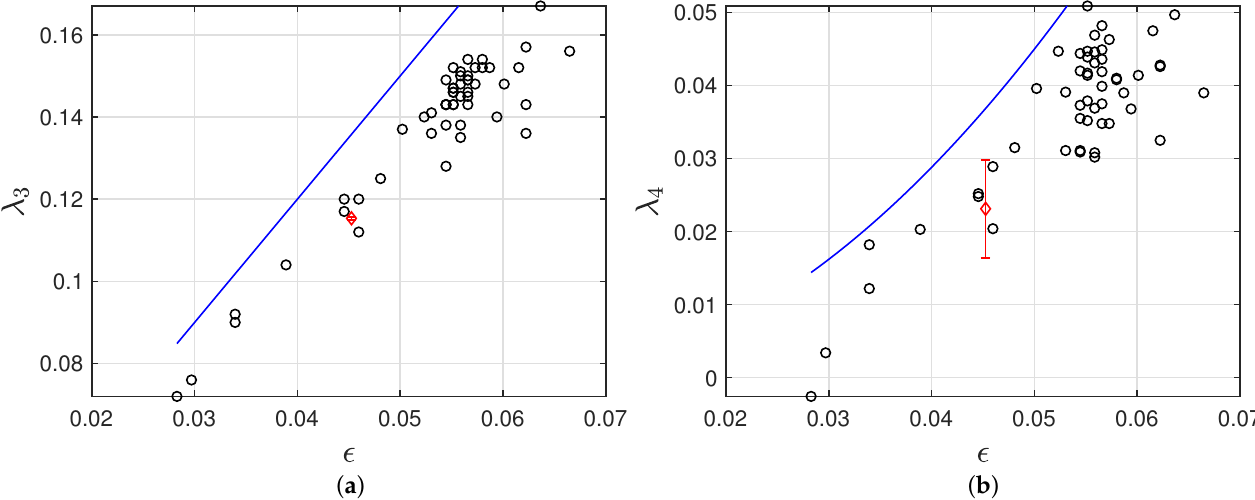
Figure 9. Dependence of skewness λ 3 ( a ) and kurtosis λ 4 ( b ) on wave steepness (cid:101) . The red diamond (cid:5) indicates case #16 (Louis Majesty accident), with error bars indicating 95% confidence interval. The blue lines represent the theoretical curves for the narrowband approximation λ 3 = 3 (cid:101) and λ 4 = 18 (cid:101) 2